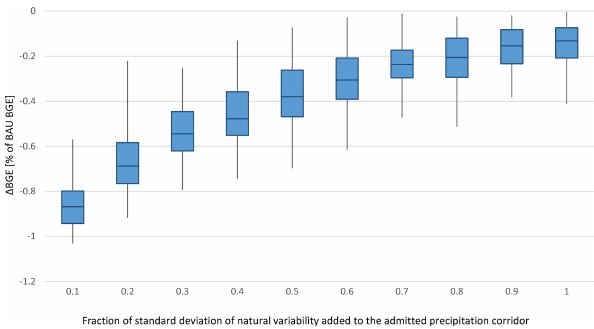
Figure 8. Monte Carlo study of SRM and CO 2 scaling coefficients. The box-and-whisker plots show the minimum, first quartile, me- dian, third quartile, and maximum BGE losses. The boxes are drawn from the first quartiles to the third quartiles. The horizontal lines go through the boxes at the medians. The whiskers go from each quar- tile to the minimums or